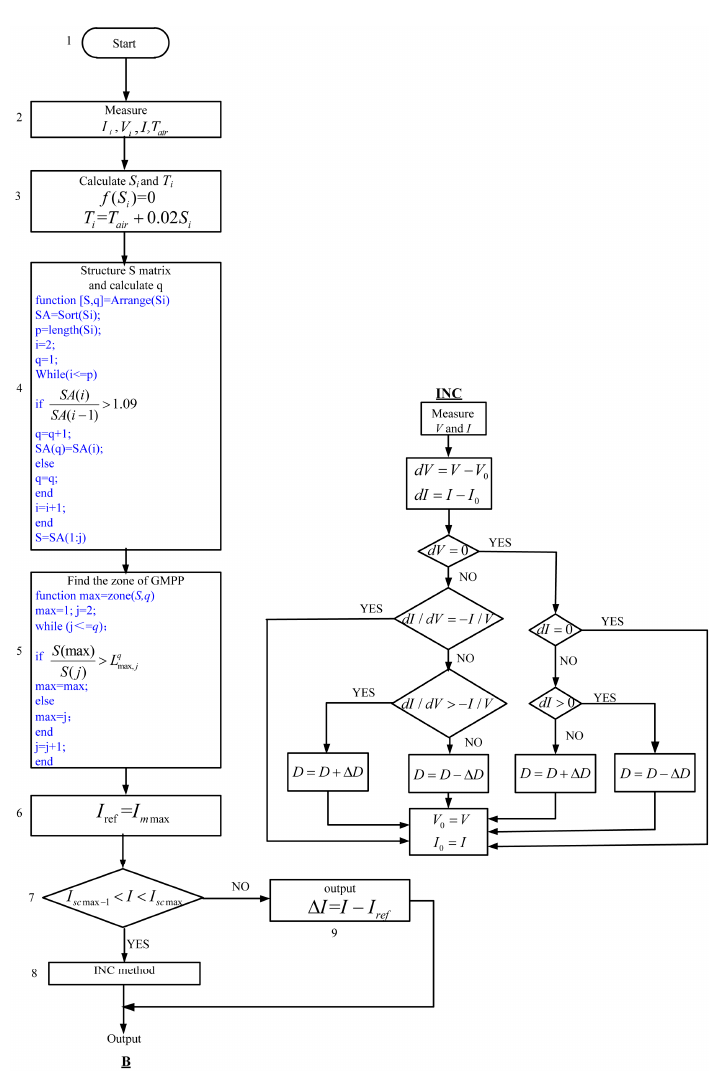
Figure 5. Flowchart for the proposed GMPPT control